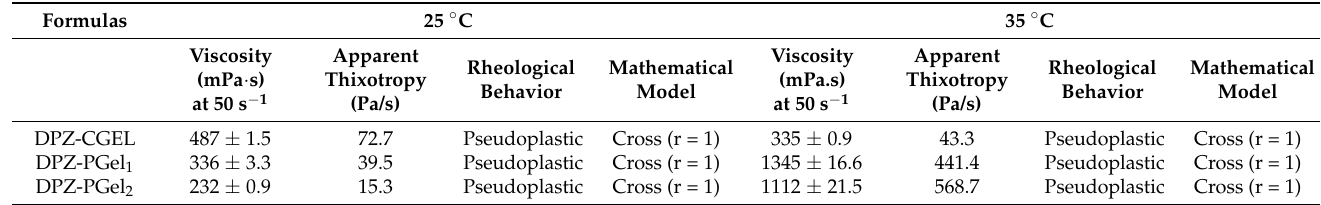
Figure 4. Flow and viscosity curves at 25 °C and 35 °C for ( A ) DPZ-CGEL, ( B ) DPZ-PGel 1 and ( C ) DPZ-PGel 2. Table 2. Viscosity, thixotropy, rheological behavior, and mathematical fitting of chitosan and Pluronic F-127